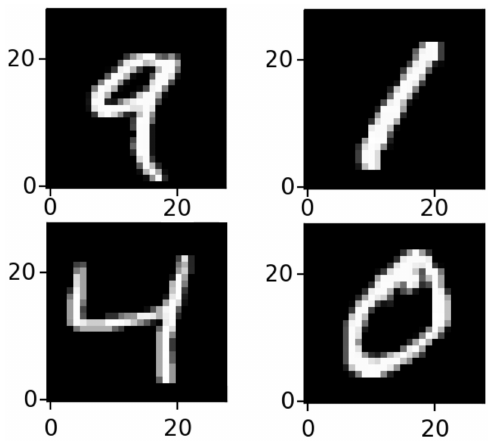
Figure 5. Example of handwritten digits from the MNIST handwritten digits